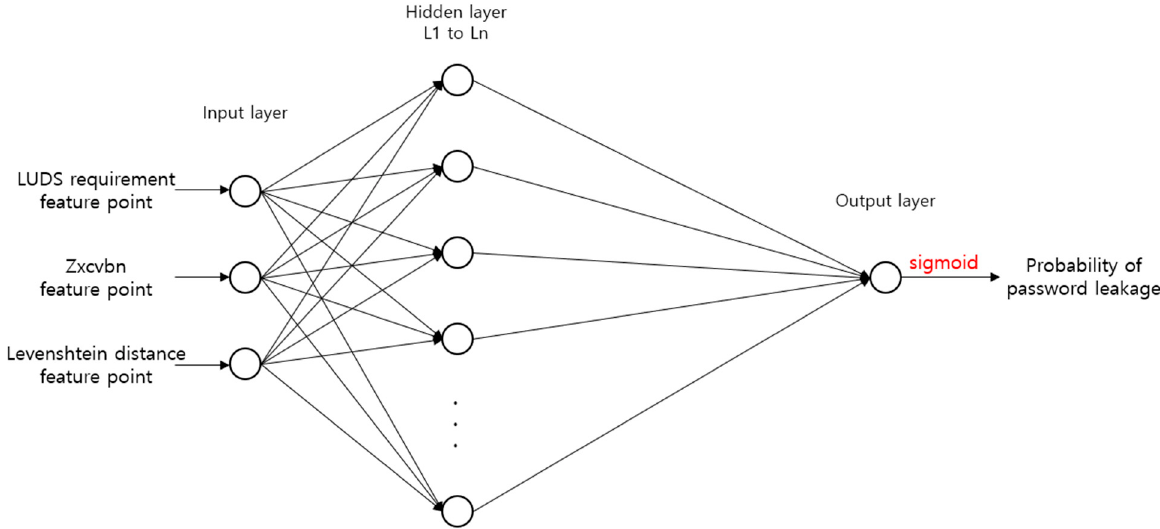
Figure 8. Structure of password evaluation model with deep learning.